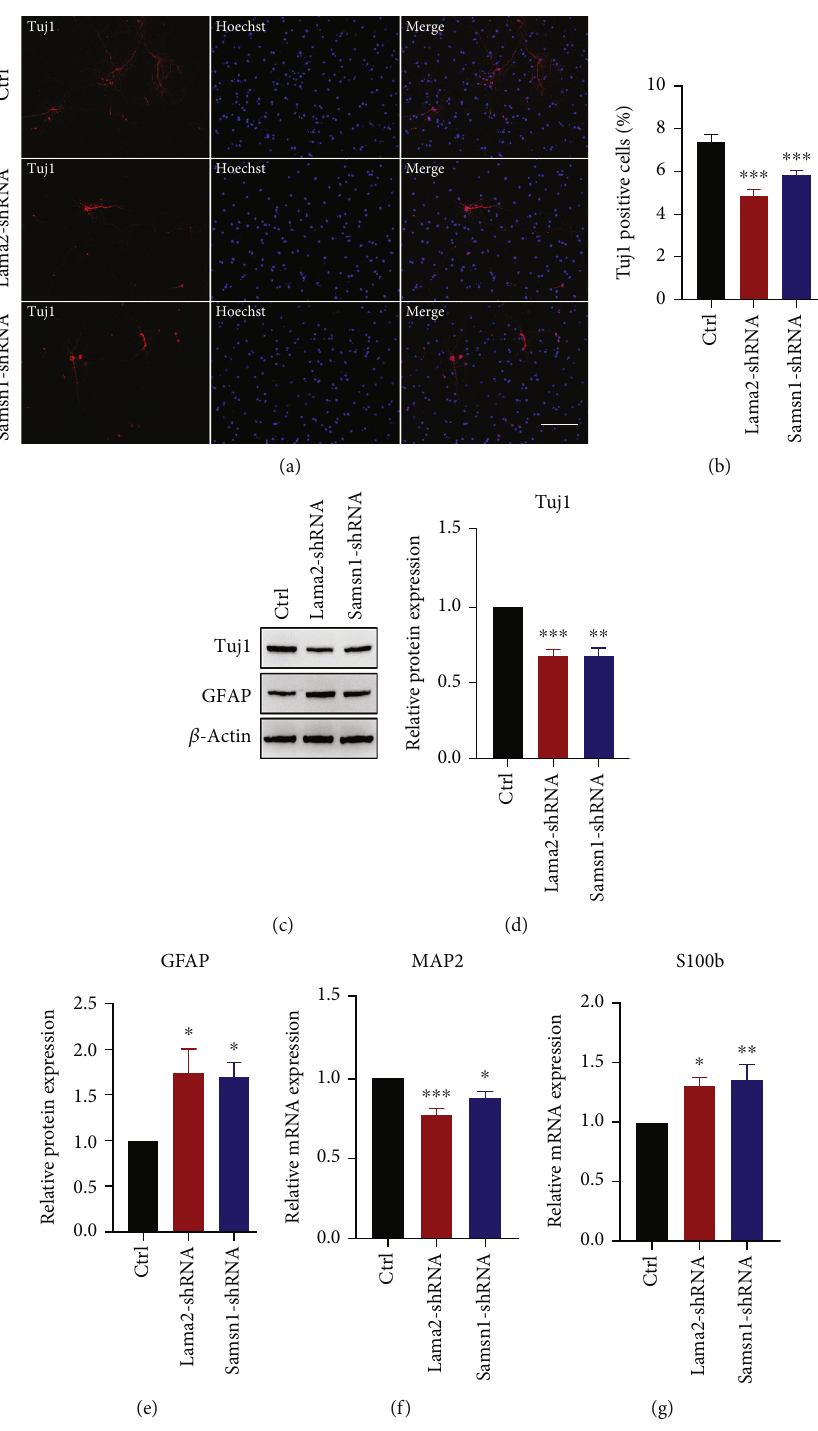
Figure 7: Lama2 or Samsn1 knockdown inhibits NSCs di ff erentiation into neurons. (a) Representative immunostaining for Tuj1 (red) in the primary hippocampal NSCs after induced di ff erentiation for 7 days following lentivirus infection. Bar = 50 μ m . (b) Quanti fi cation of Tuj1- positive cells normalized to Hoechst. (c – e) Representative immunoblots of Tuj1, GFAP, and β -actin in the primary hippocampal NSCs after induced di ff erentiation for 7 days following lentivirus infection (c) and quanti fi cation of Tuj1 and GFAP protein levels normalized to β -actin (d, e). (f, g) Quanti fi cation of MAP2 and S100b mRNA levels normalized to β -actin after the NSCs induced di ff erentiation for 7 days following lentivirus infection. Error bars represent the mean ± SEM . n = 3 . ∗ P < 0 : 05 , ∗∗ P < 0 : 01 , ∗∗∗ P < 0 : 001